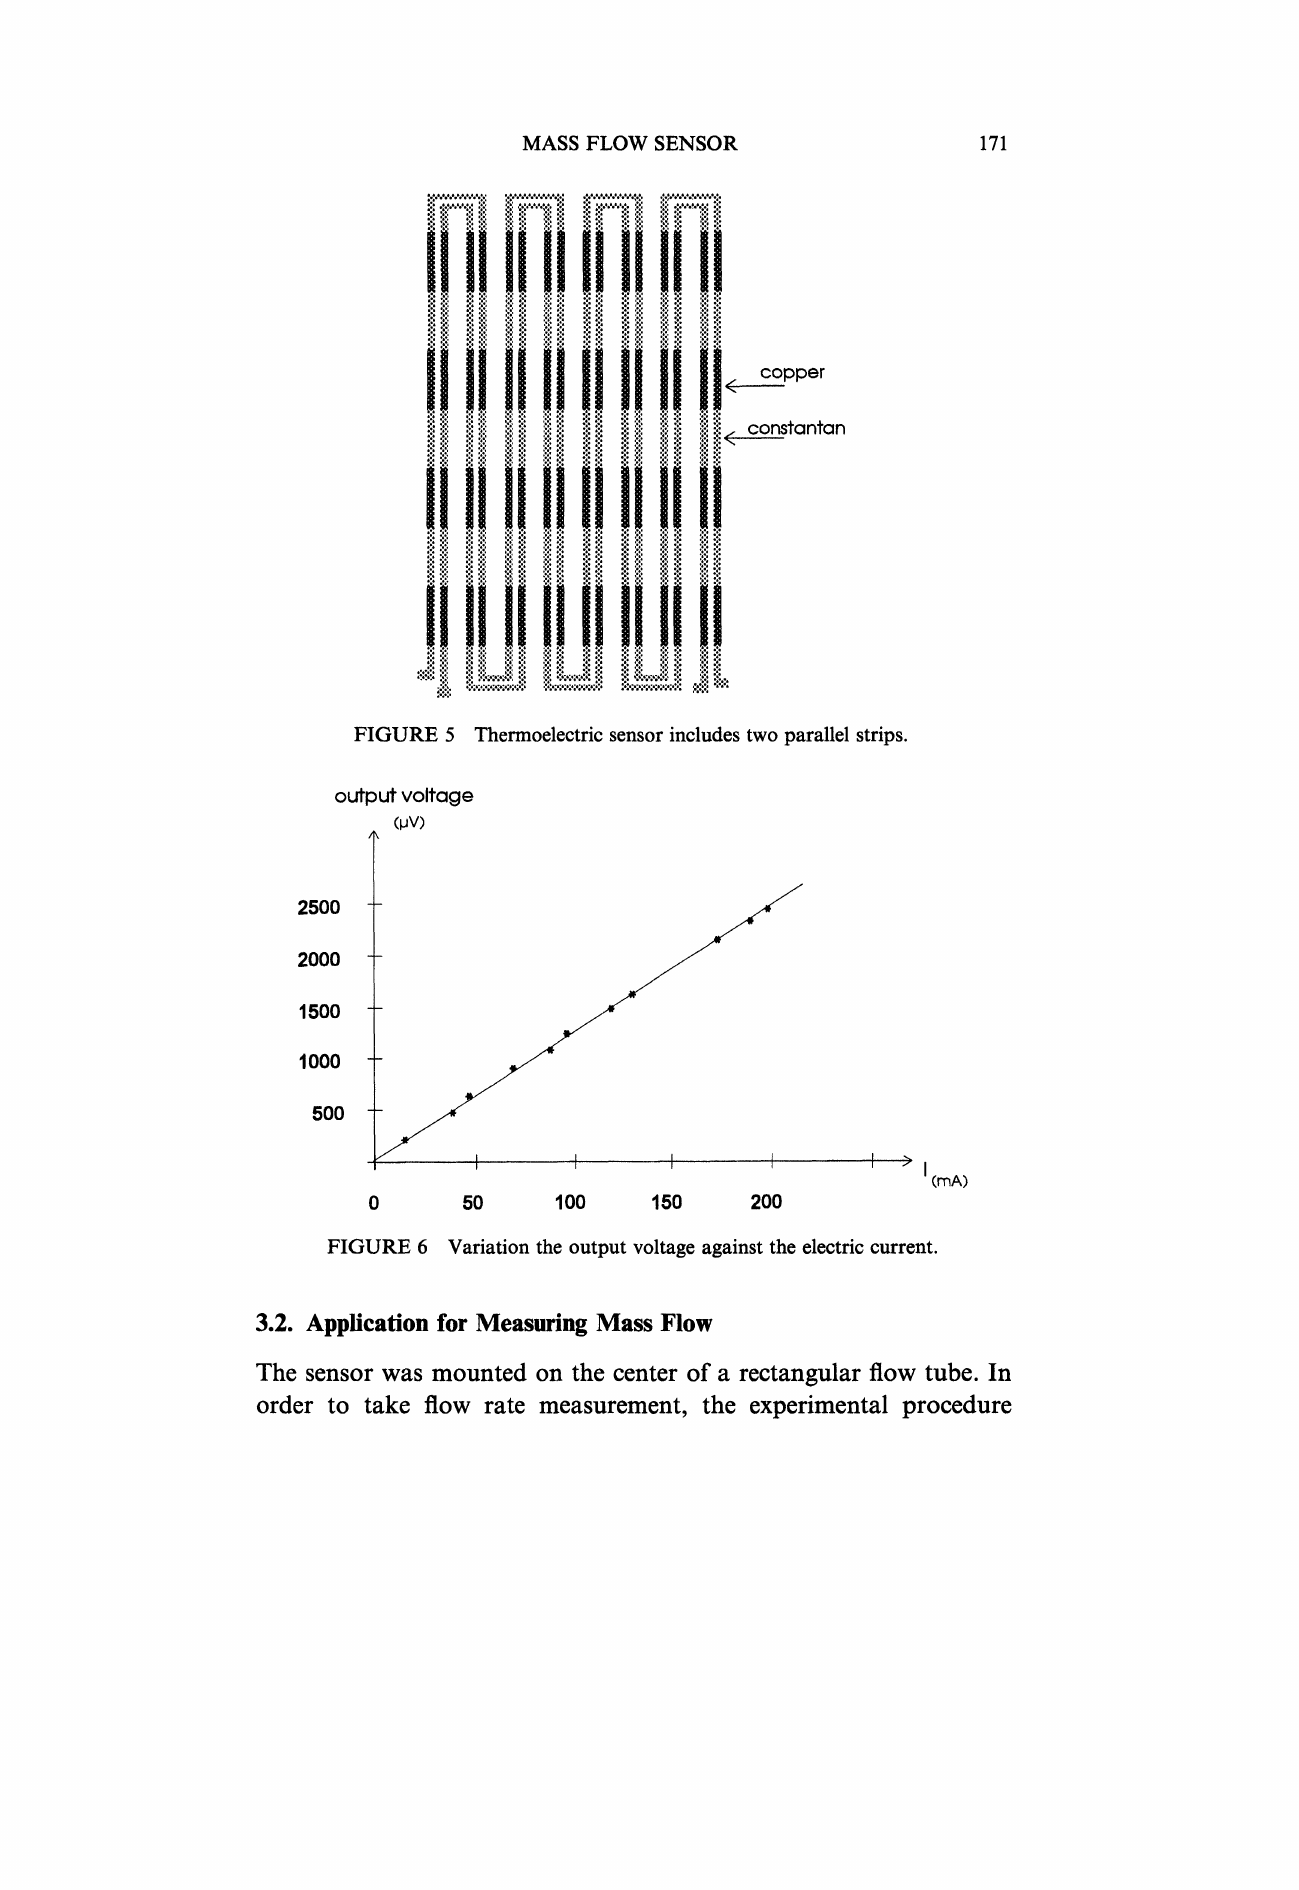
FIGURE 5 Thermoelectric sensor includes two parallel strips.